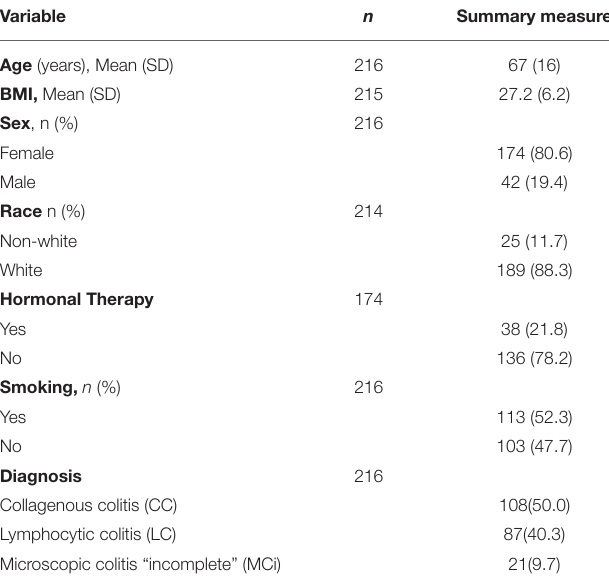
TABLE 1 | Clinical characteristics of